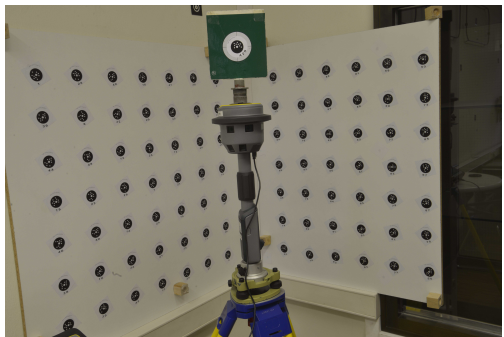
Figure 5: Typical image to get the offset between the camera projection center and a mounted target.